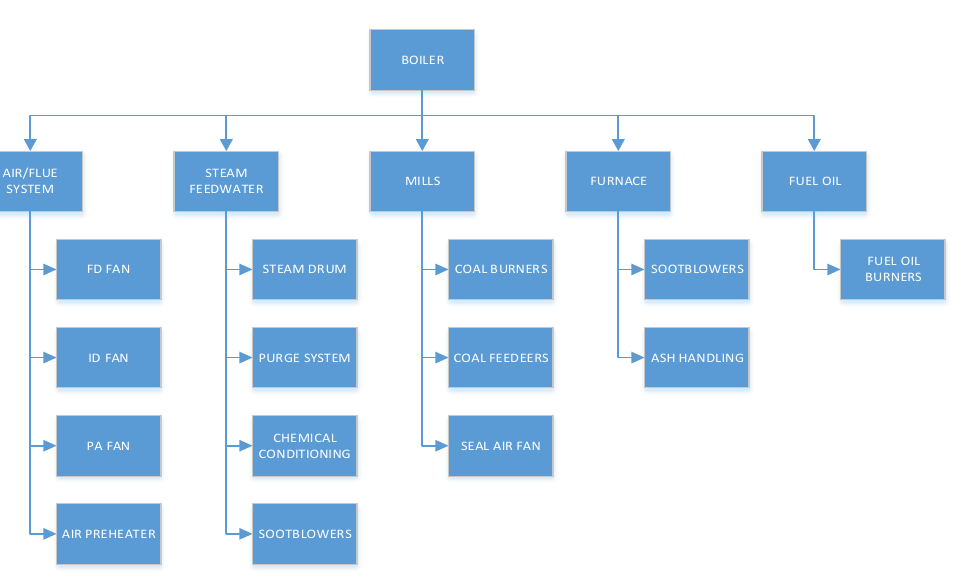
Table 4. Systems and subsystems monitored in the boiler.